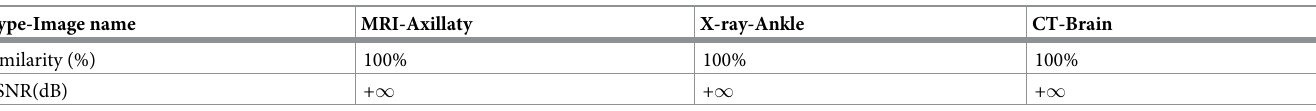
Table 12. Comparison table of similarity and PSNR.